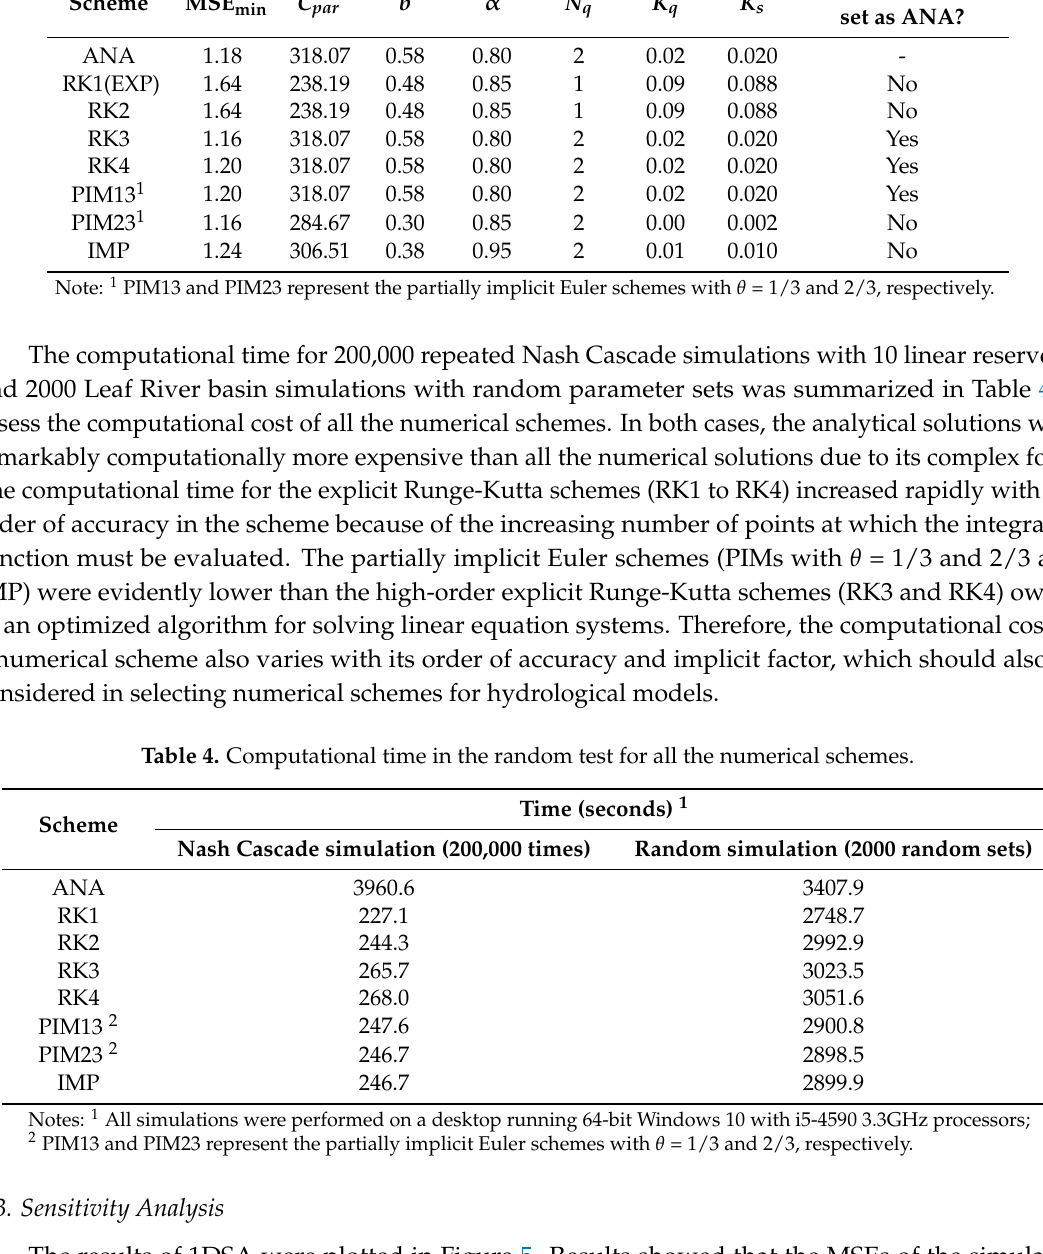
Same Parameter set as ANA?